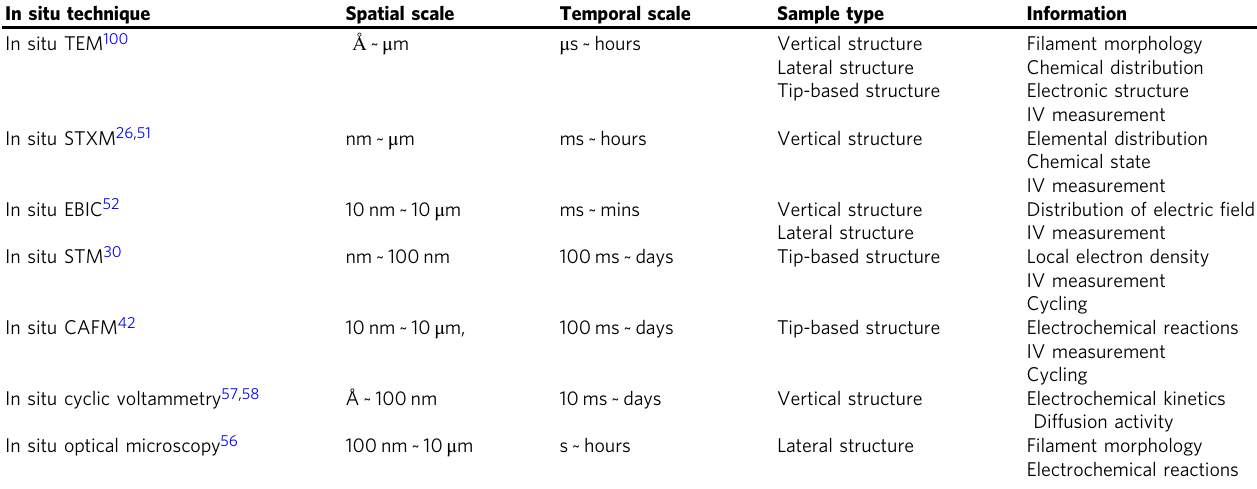
Table 2 Features of various in situ techniques for investigating the switching mechanism In situ